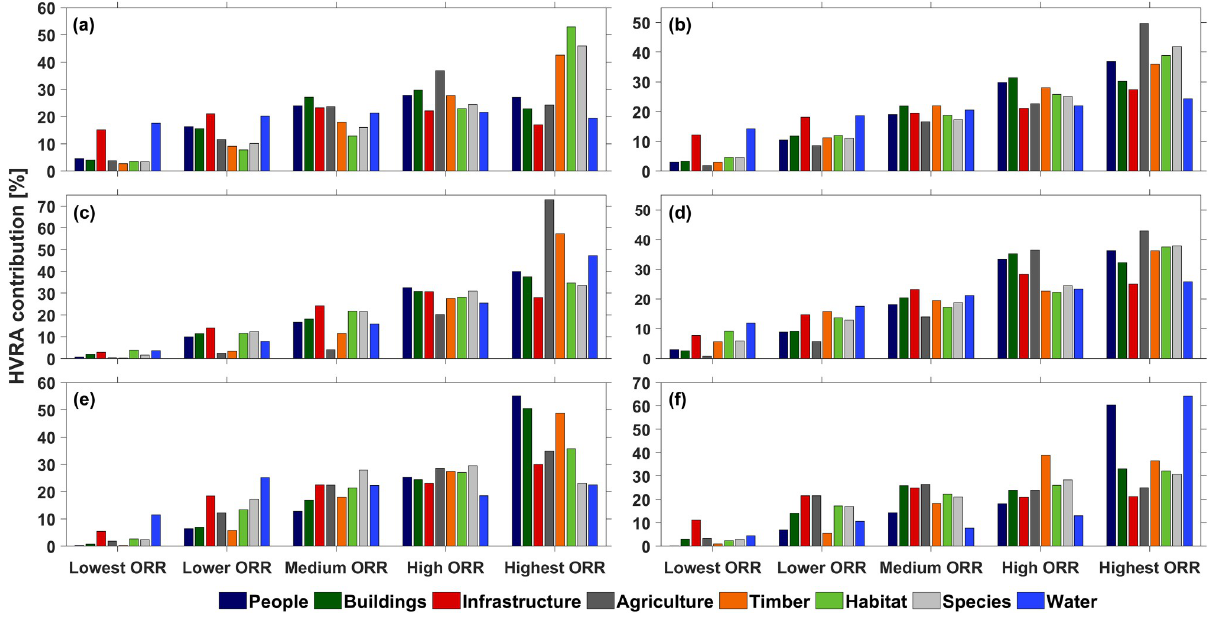
Fig 9. Percent ORR distribution across all risk classes with respect to the HVRA main categories for FSA 1 to 6 (panel a to f).